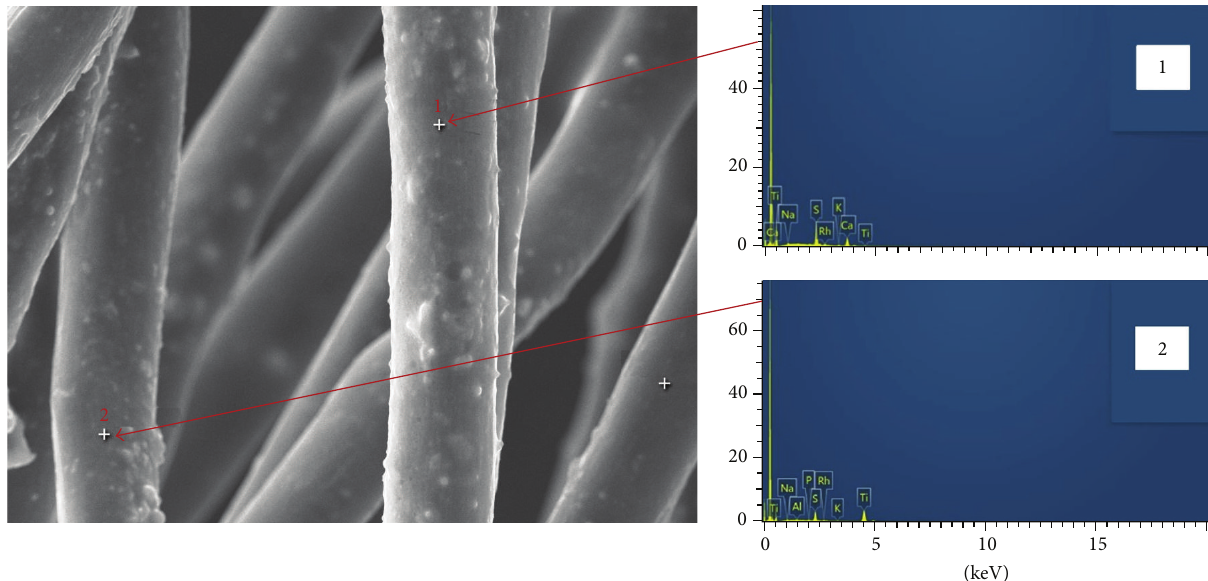
Figure 6: SEM image ( × 1100) and EDX analysis of an ashless filter used for the filtration of Rh electrolyte. The elemental composition (wt.%) in point (1) is S 45.8, Ca 34.4, Rh 10.5, Na 4.2, K 3.5, and Ti 1.6, and in point (2)-Ti 63.9, S 21.3, Rh 6.3, Na 3.6, P 1.7, Al 1.6, and K